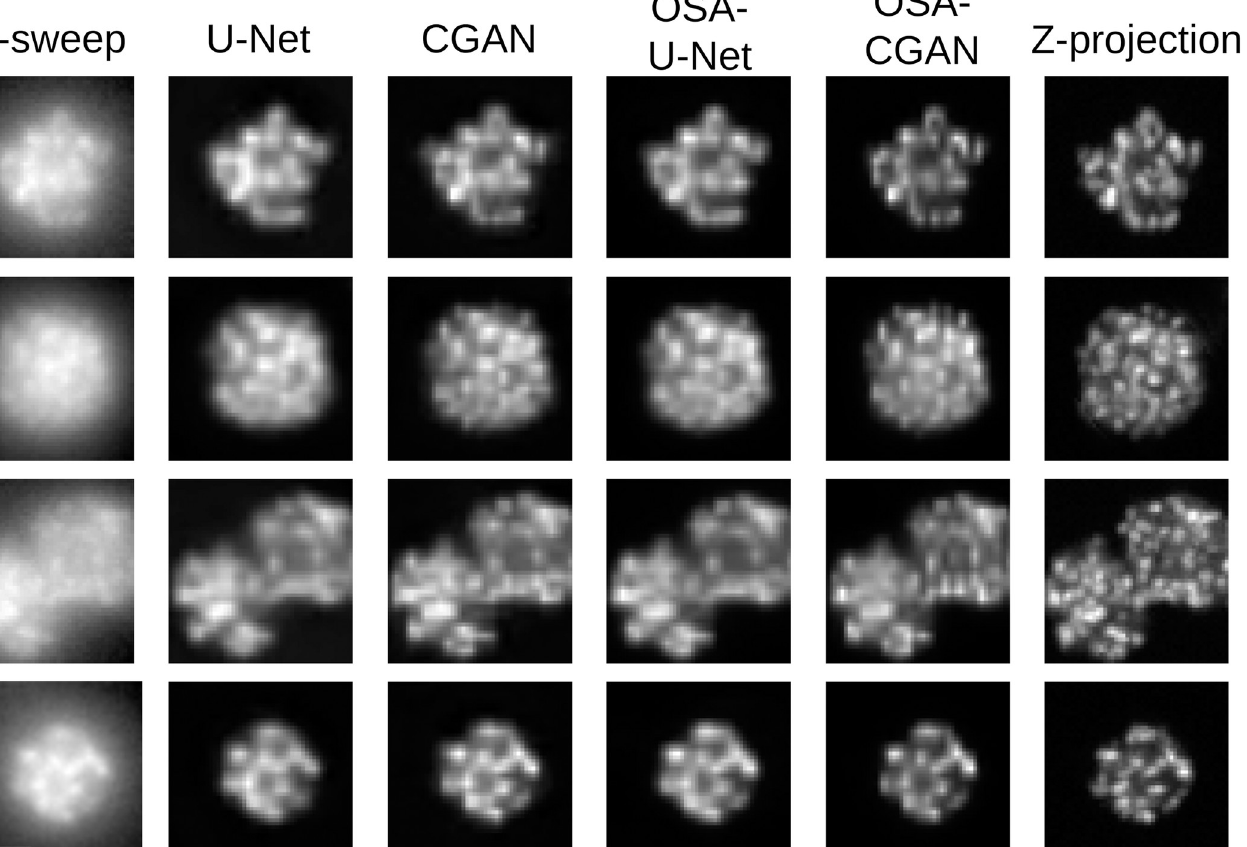
PLOS ONE | https://doi.org/10.1371/journal.pone.0264241 May 19,